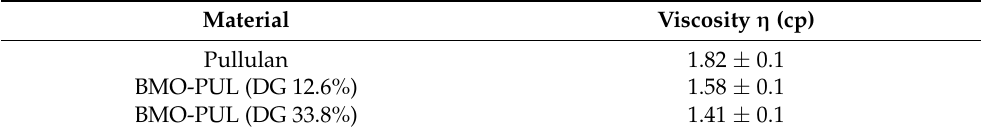
Table 3. BMO-PUL derivatives viscosity data ( n = 3; ± SD).